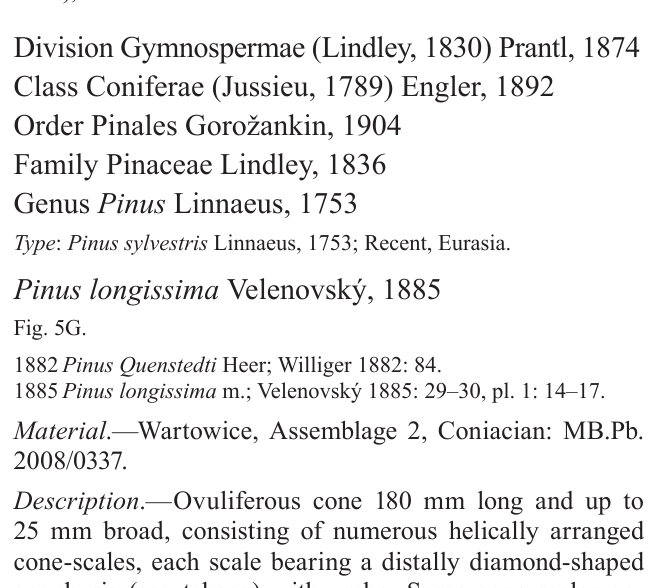
Fig. 5. Late Cretaceous conifers from the North Sudetic Basin, Lower Silesia, Poland. A – C . Twig fragments of Geinitzia reichenbachii (Geinitz, 1842) Hollick and Jeffrey, 1909. A . MB.Pb.2008/0240, Rakowice Małe, Assemblage 5 (upper Coniacian?–lower Santonian?). B . MB.Pb.2018/0049, Bolesławiec, Assemblage 8 (Santonian). C . MB.Pb.2008/0363, Rakowice Małe, Assemblage 5 (upper Coniacian?–lower Santonian?). D , F . Cone scales of Protodammara sp. D . MB.Pb.2018/0078, Rakowice Małe, Assemblage 5 (upper Coniacian?–lower Santonian?). F . MB.Pb.2018/005 with amber pieces, Rakowice Małe, Assemblage 5 (upper Coniacian?–lower Santonian?); see colour photograph in Fig. 2C. E . Geinitzia cf. formosa Heer, 1871. Ovuliferous cone longitudinally broken (part and counterpart) MB.Pb.2008/250a, b, Rakowice Małe, Assemblage 5 (upper Coniacian?–lower Santonian?). G . Pinus longissima Velenovský, 1885. Ovuliferous cone MB.Pb.2008/0337, Wartowice, Assemblage 2